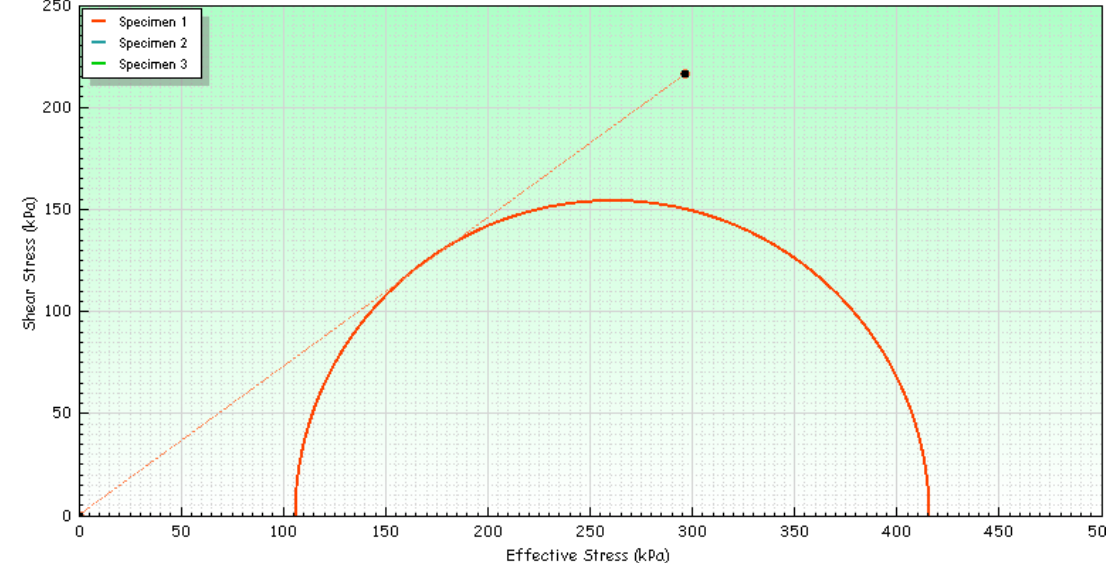
Figure A10. Mohr circle obtained in study of molding sand in triaxial compression apparatus.